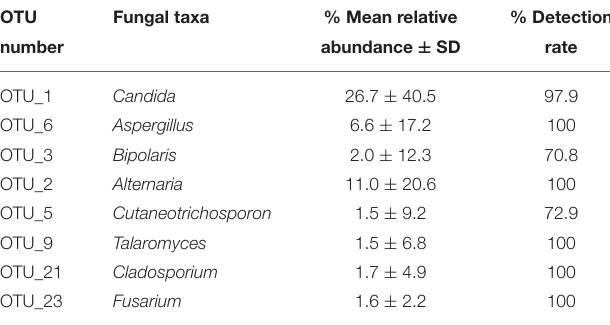
TABLE 2 | Predominant genera in all samples (mean relative abundance >